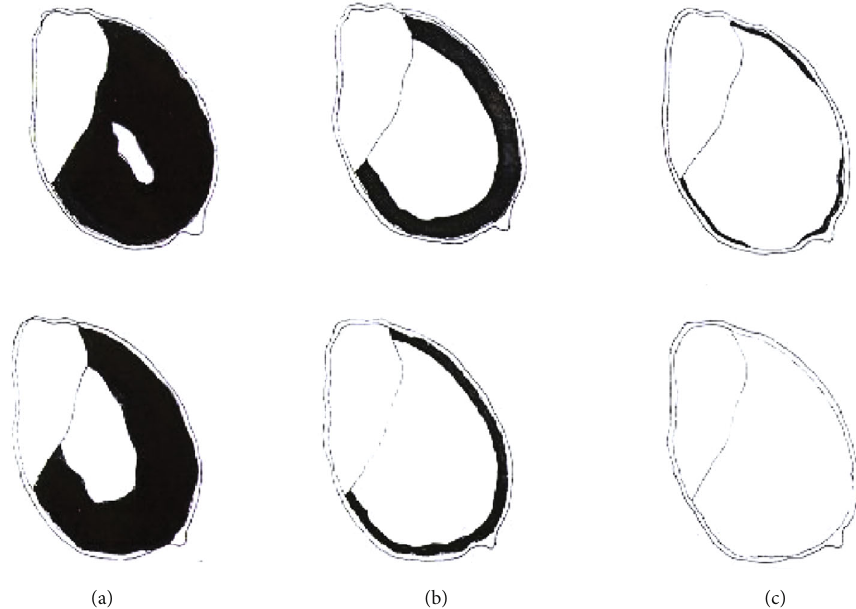
Figure 1: Illustration of sorghum grain endosperm texture. (a) Corneous; (b) intermediate; (c) fl oury. The corneous endosperm is totally or > 50% translucent endosperm. The intermediate endosperm has a continuous outer corneous endosperm comprising < 50% of total endosperm while the inner endosperm is fl oury. The fl oury endosperm is totally fl oury or its outer corneous endosperm is very narrow and incomplete (adapted from Taylor and Taylor